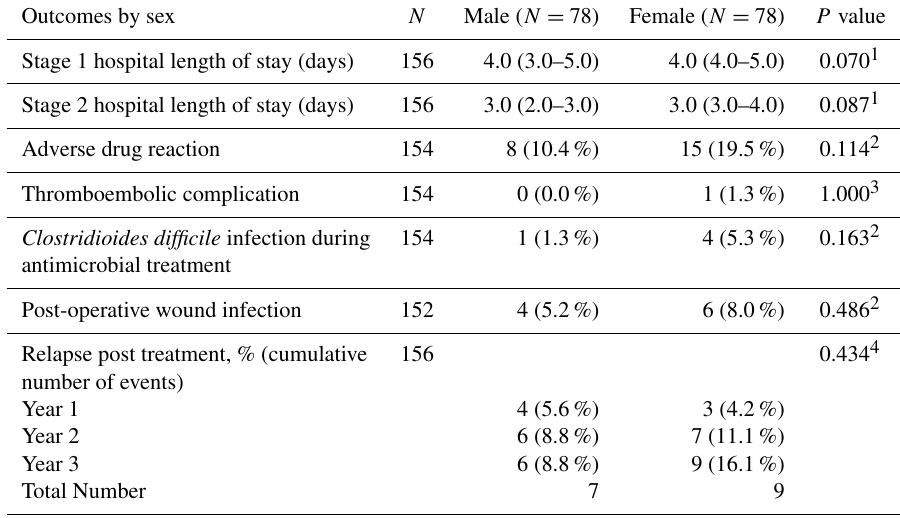
Values represent median (IQR) for continuous outcomes, frequency (percentage) for binary outcomes, and Kaplan–Meier cumulative incidence estimates for time-to-event outcomes. N is the number of non-missing values. P values are by 1 Wilcoxon rank sum, 2 Pearson χ 2 , 3 Fisher exact, or 4 log-rank